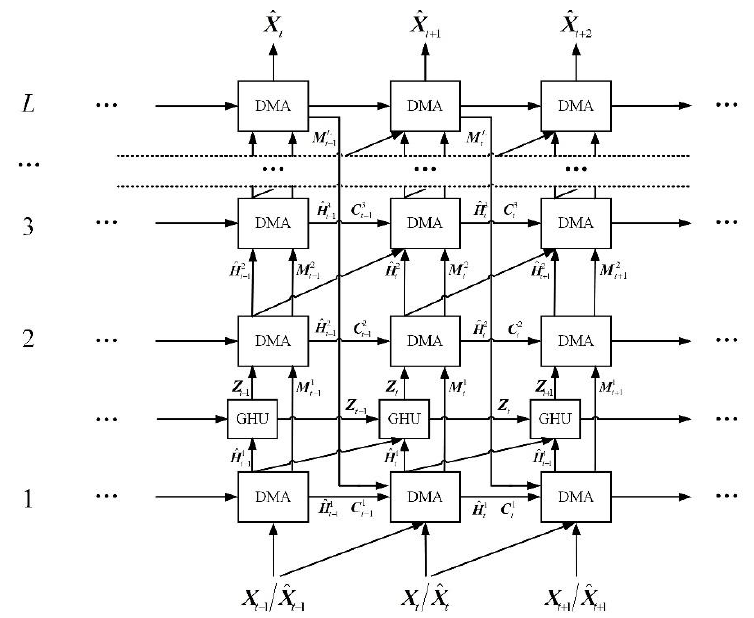
Figure 5. DMANet. Figure 5.